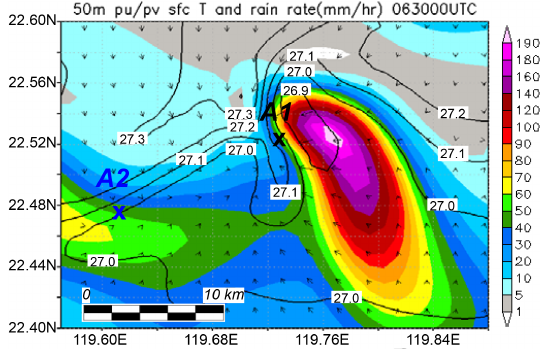
Figure 11. As in Fig. 9a, but showing model-simulated surface air temperature ( ◦ C, contours, intervals: 0.1 ◦ C), horizontal wind perturbation ( u (cid:48) , v (cid:48) ) at 50m (ms − 1 , vectors, reference vector at bottom), and (instantaneous) rain rate (mmh − 1 , color, scales on the right) at 06:30UTC, 8 August 2009. The “x” marks the up- draft/ascending centers of A1 and A2 at